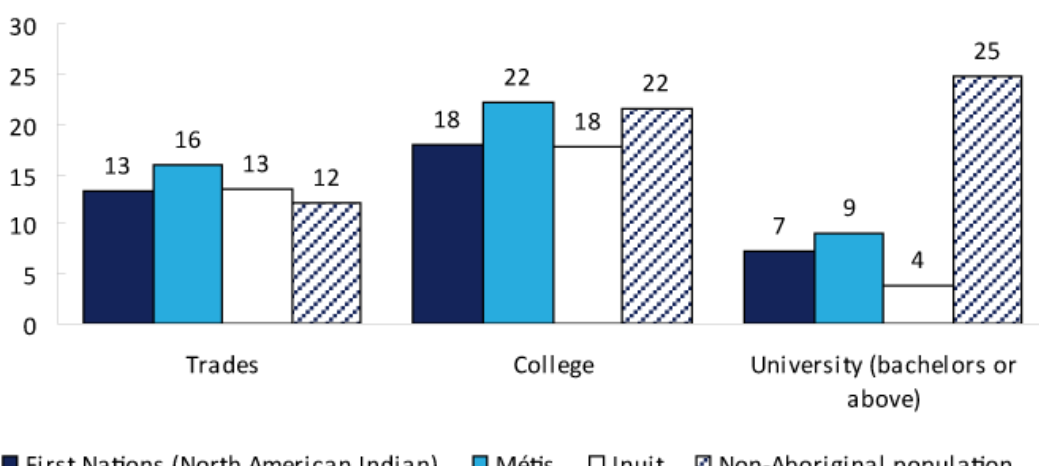
Figure 1 . Postsecondary educational attainment by Aboriginal identity, population aged 25 to 54,